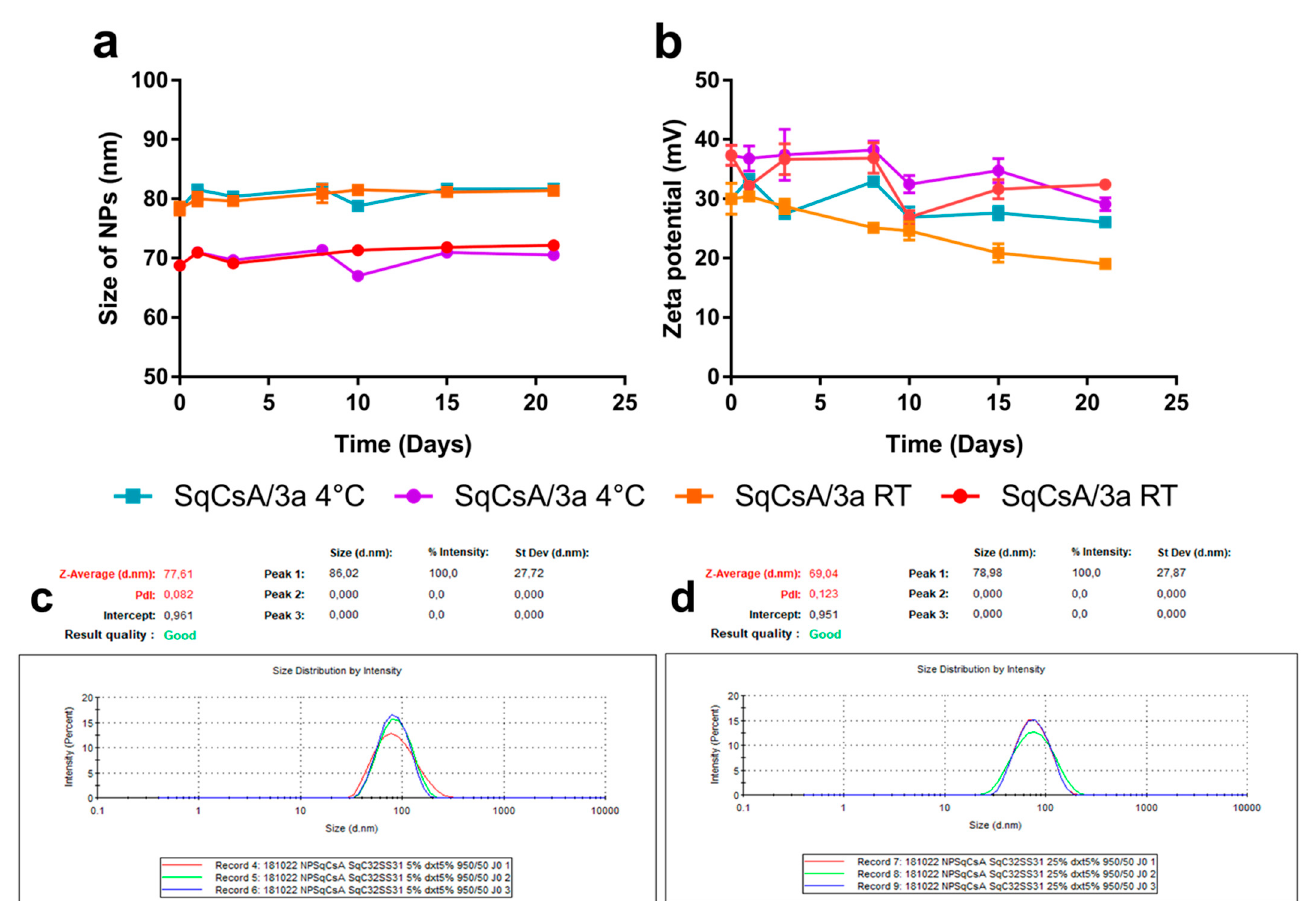
Figure 4. Colloidal stability of SqCsA/ 3a NPs in size ( a ) and zeta potential ( b ) comparing ratio and storage conditions (4 °C and RT). Circle and squares correspond, respectively, to ratio 75:25 and 95:5. Particle size distribution of SqCsA/3a NPs at 95:5 ( c ) and 75:25 ( d ) ratios. Particle size distribution of SqCsA/3a NPs at 95:5 ( c ) and 75:25 ( d )